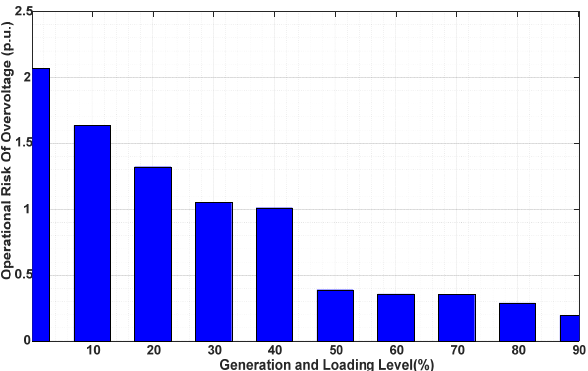
Figure 4. Operational risk of overvoltage as a function of GLL.